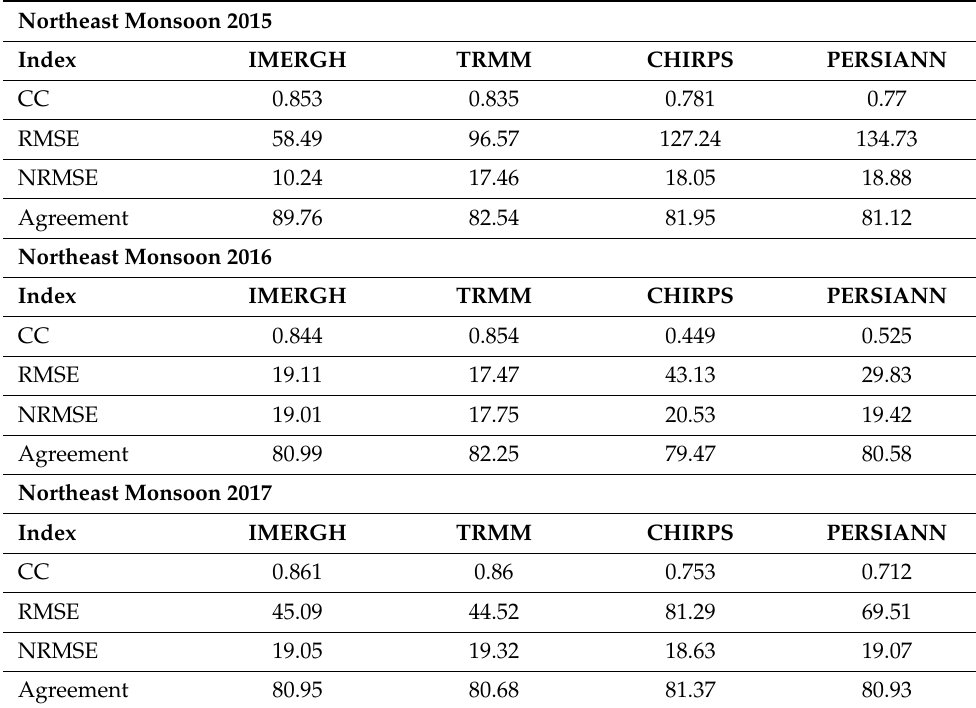
Table 5. NEM statistical evaluation of satellite precipitation products during